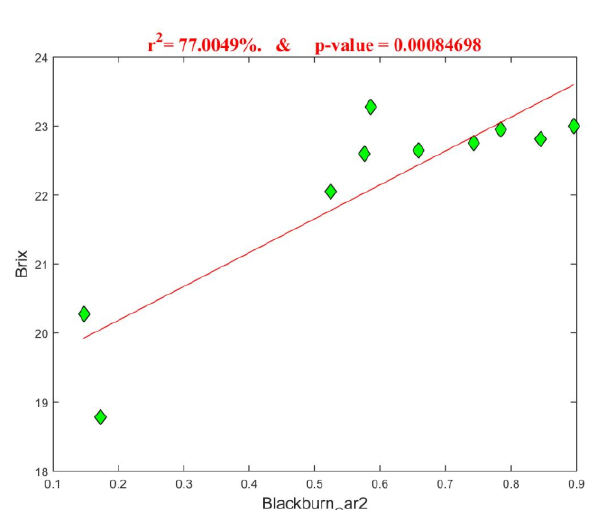
Table 6. The highest correlation rates regarding the estimation of BRIX levels for Xinomavro in 2013